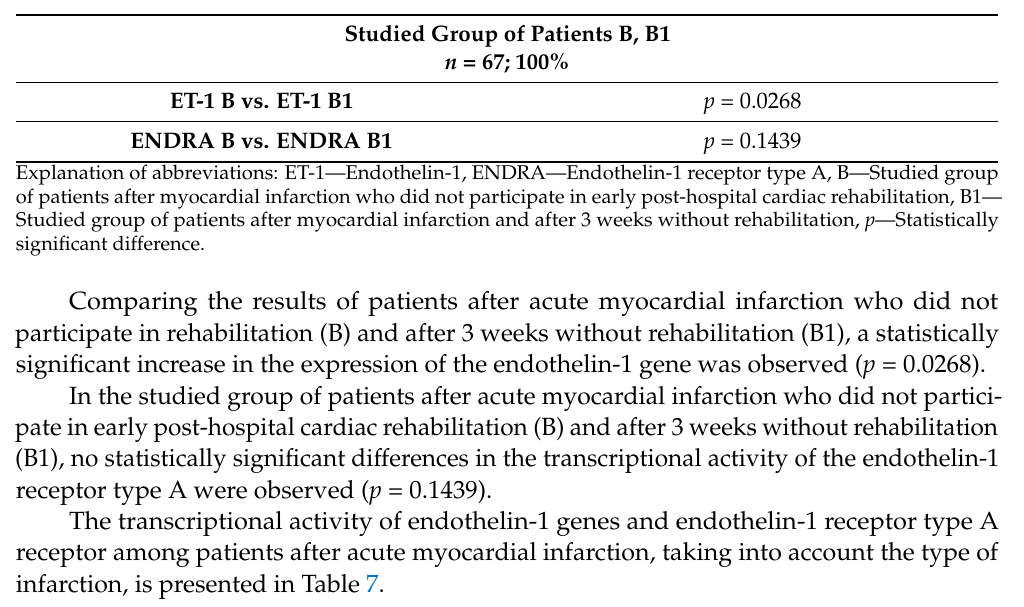
Table 7. Transcriptional activity of endothelin-1 genes and endothelin-1 receptor type A recep- tor in the studied group of patients after myocardial infarction, taking into account the type of myocardial